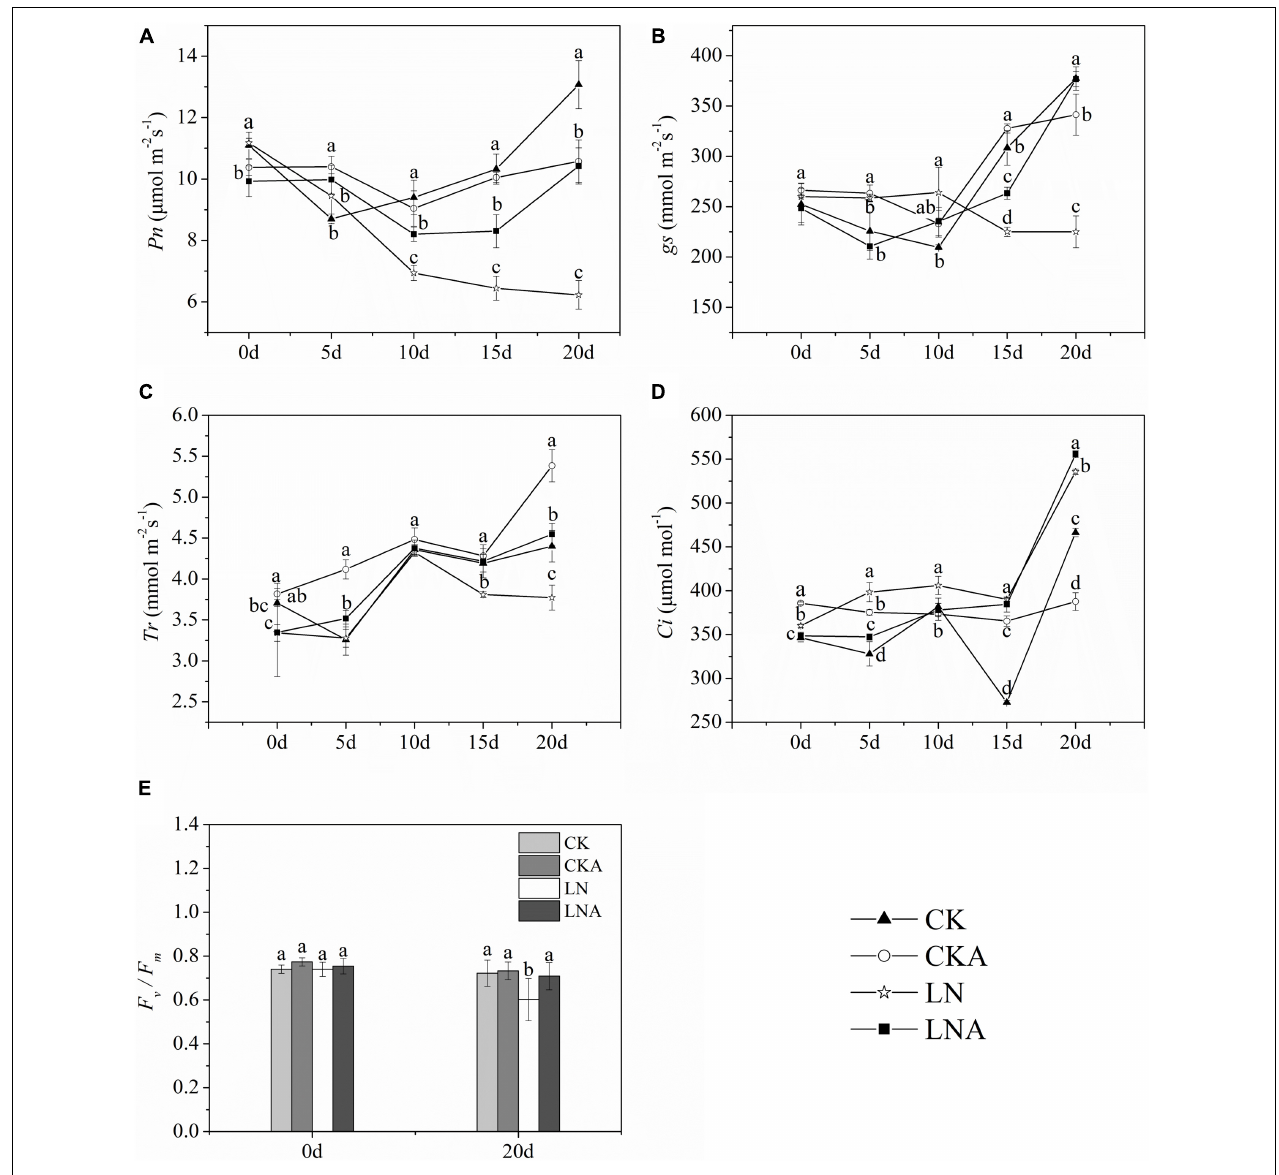
FIGURE 7 | Changes in the photosynthetic system of M. hupehensis. Net photosynthetic rate ( Pn , A ), stomatal conductance ( gs , B ), transpiration rate ( Tr , C ), intercellular CO 2 concentration ( Ci , D ), and F v /F m (E) of CK, CKA, LN, and LNA after 20 days. Values are the means of ten replicates ± SD. Values not represented by the same letter are significantly different according to Tukey’s multiple-range test ( P <